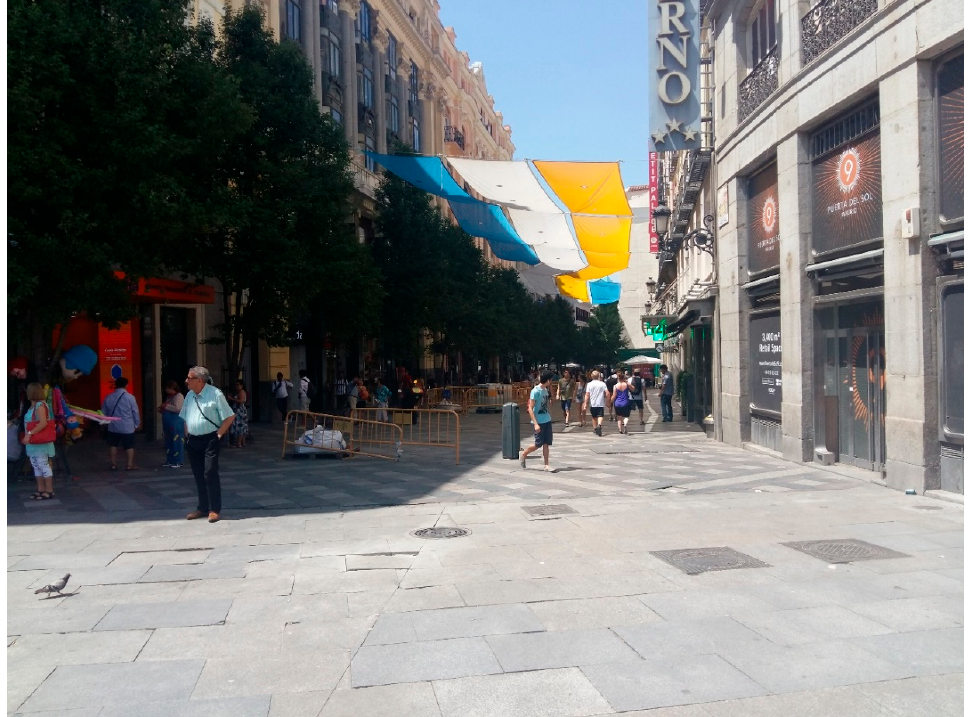
Figure A7. Canopies over sunny streets in summer.